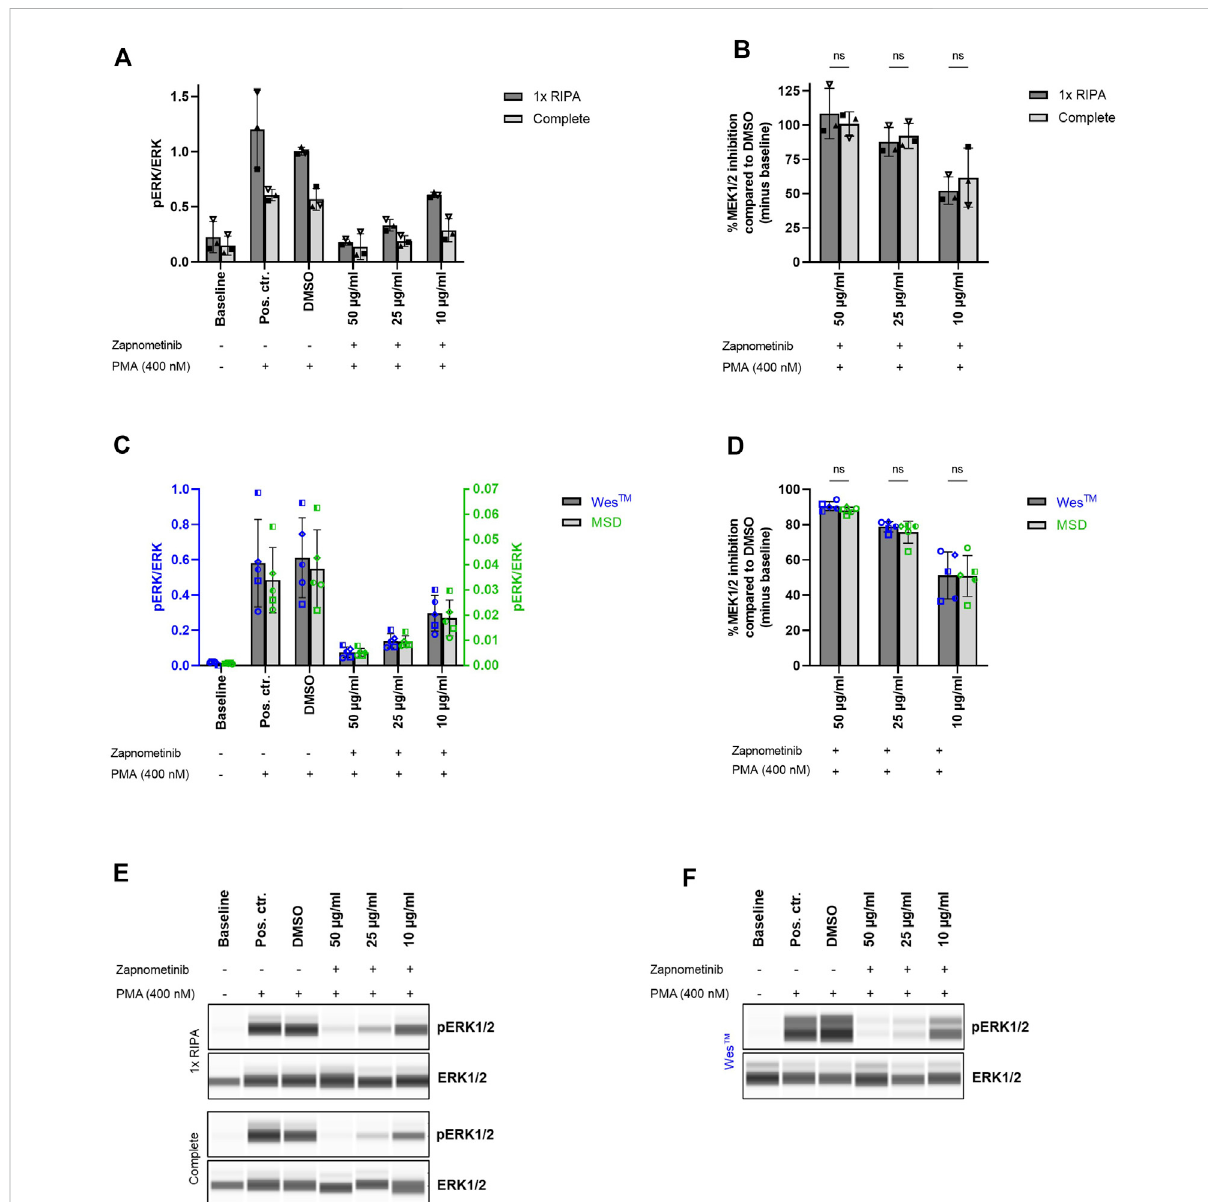
FIGURE 4 Comparable results for sample analysis with Wes ™ and MSD system. (A,B) Comparison of cell lysis using 1x RIPA or Complete lysis buffer as preliminary step for Wes ™ and MSD system comparison. Cell treatment was performed as previously described and cells were lysed using either 1x RIPA(dark grey)orComplete lysis buffer(light grey). TheERK1/2phosphorylation statuswas assessed with theWes ™ system.Two-way ANOVA with Š ídák correction was used for statistical analysis to compare the results obtained for cell lysis using 1x RIPA or Complete lysis buffer. ns, not statistically signi fi cant. N = 3 blood donors. (C,D) Comparison of (C) pERK/ERK (ratio of phosphorylated ERK1/2 to total ERK1/2) and (D) %MEK1/ 2 inhibition upon sample analysis with the Wes ™ and the MSD system. Cell treatment and lysis was performed as previously described and the samples were analyzed with the Wes ™ (dark grey bars, blue datapoints) and the MSD system (light grey bars, green datapoints). Two-way ANOVA with Š ídák correction was used for statistical analysis to compare the results obtained with Wes ™ and MSD platform. ns, not statistically signi fi cant. N = 5 blood donors. Data are displayed as (A,C) ratio pERK/ERK and (B,D) %MEK1/2 inhibition compared to DMSO. Data are presented as individual values and mean with standard deviation. Each datapoint represents one blood donor. (E,F) Presentation of pERK1/2 and ERK1/2 levels as Western blot-like bands of one representative blood donor included in (A,B) or (C,D) , respectively. The Western blot-like band data of all blood donors is shown in the Supplementary